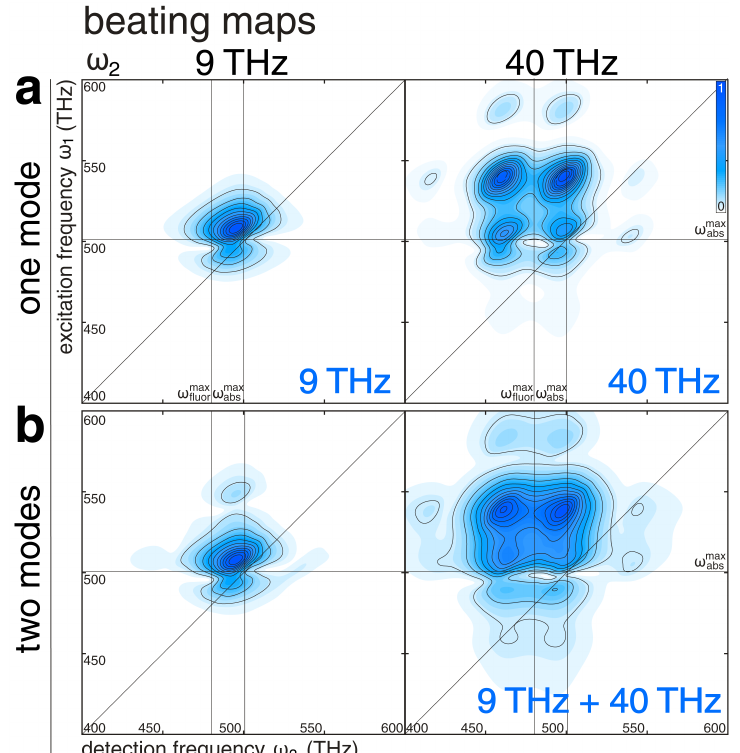
Figure 5. Beating maps (magnitude) shown at ω 2 = 9 THz or 40 THz. Beating maps were obtained from 3D electronic spectra simulated using ( a ) one mode with frequency ω 0 = 9 THz or 40 THz, and ( b ) two modes with frequencies ω 0 = 9 THz + 40